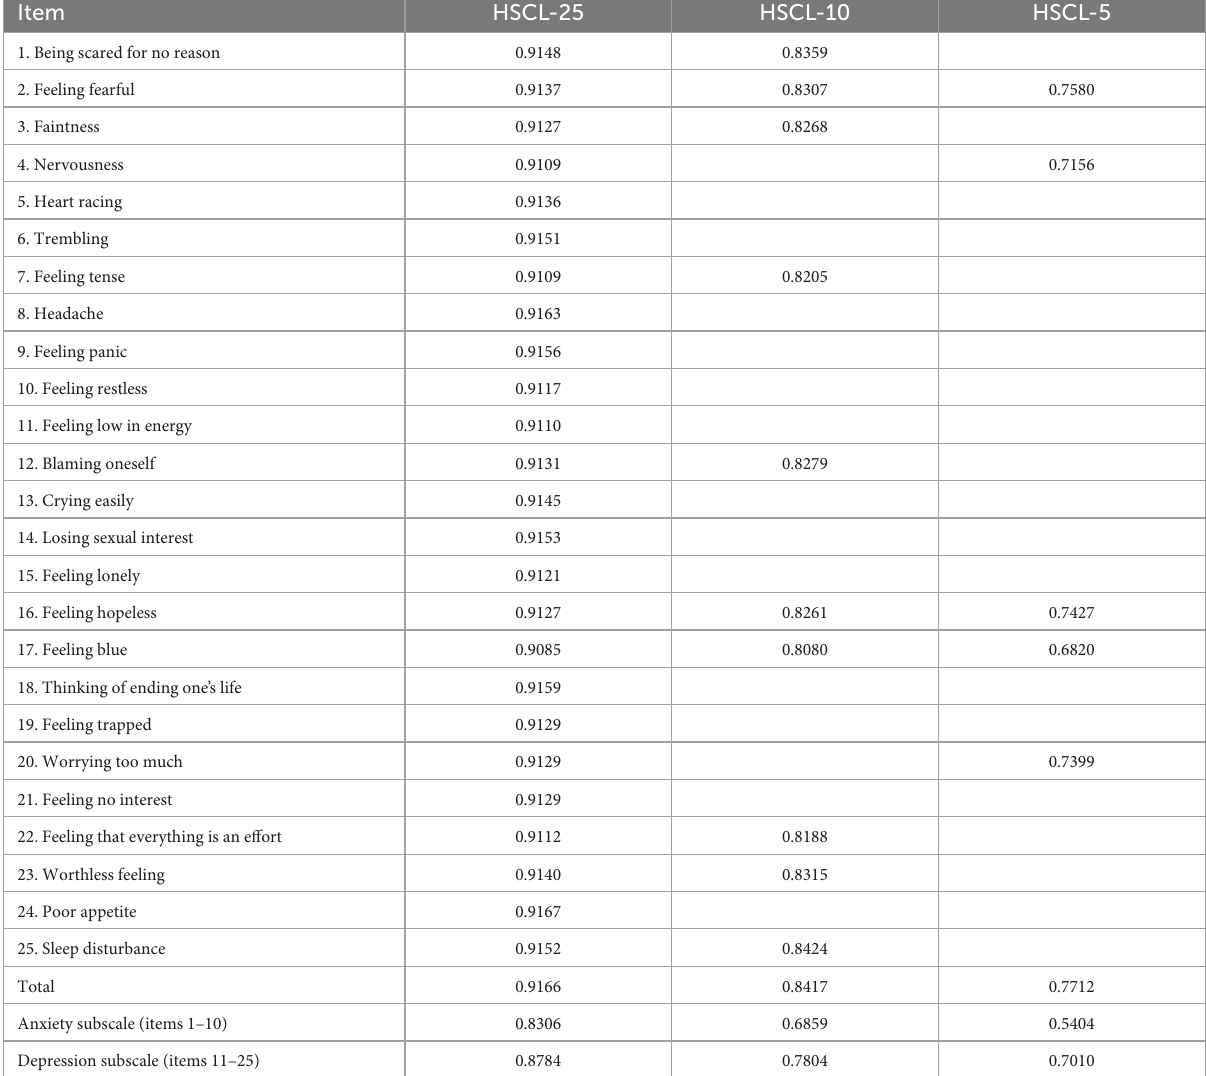
TABLE 3 Cronbach’s alpha coefficient without the item and for total